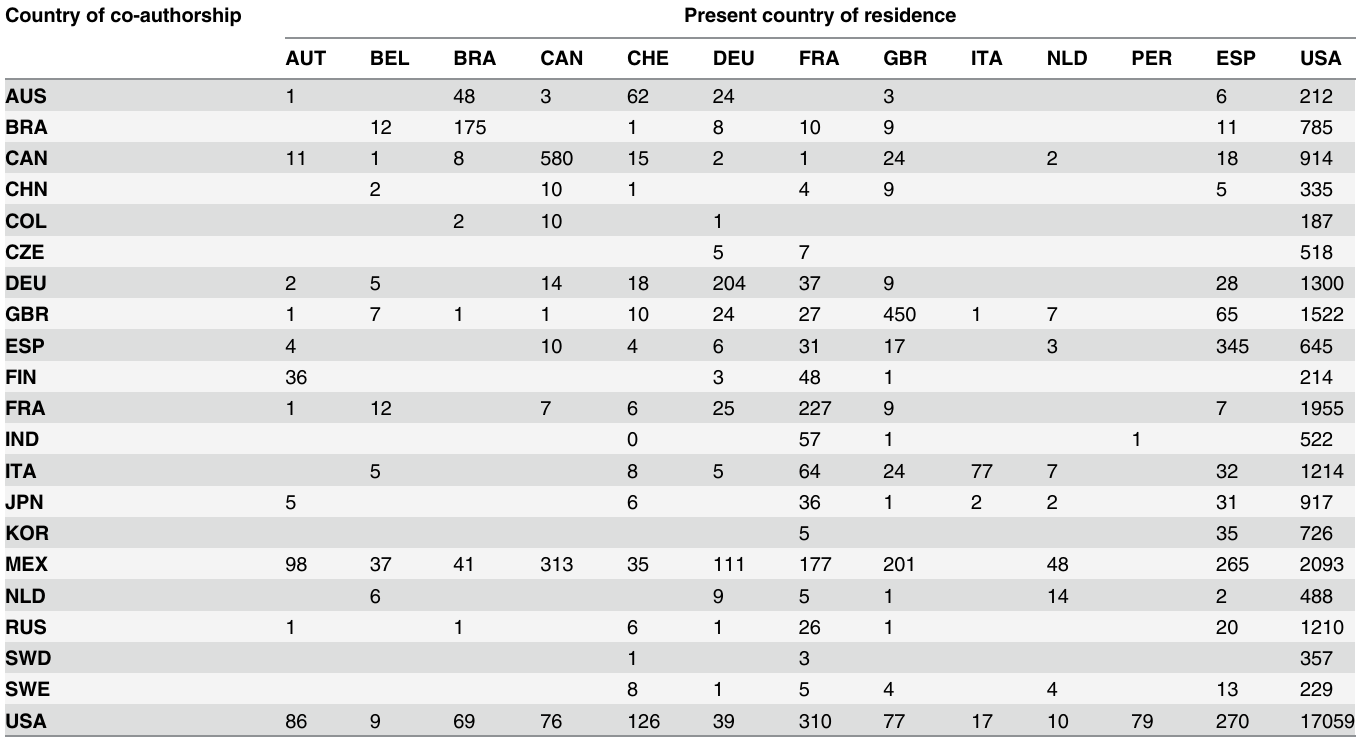
Table 4. Distribution of co-authored papers published by the Mexican Diaspora by current country of residence and country involved in the collaboration. Country of co-authorship